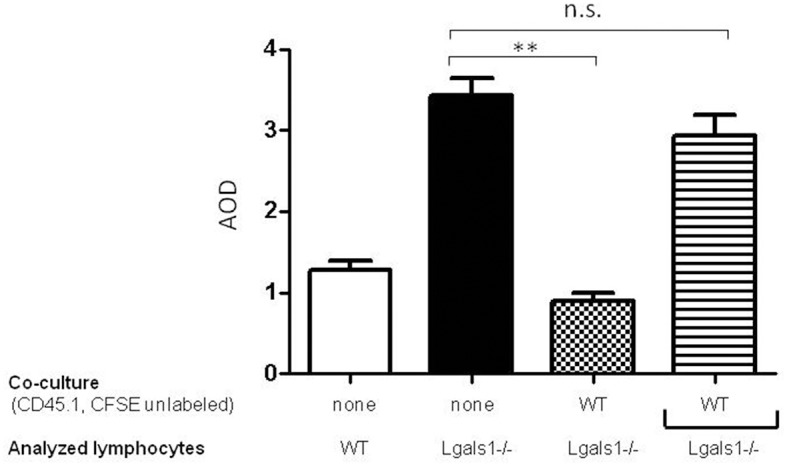
Endogenous Gal-1 regulates lymphocyte proliferation through cell-to-cell contacts. Lymphocytes from Lgals1-/- (black bars) and wild type (white bars) mice were polyclonally activated in presence of 1% TRAMP-C1 cells and 10% APC. Additionally, Lgals1-/- (CFSE labeled) and wild type (CD45.1; CFSE-) lymphocytes were co-cultured together or separated through a transwell. In all cases activation was performed by 0.25 μg/ml soluble anti-CD3 mAb. Proliferation was evaluated at 72 h by CFSE dilution in the CD8+ CD45.2+ gate. Results are expressed as average stage of division (AOD) and represent the mean + SD of three experiences. Statistic significance **p < 0.01 (Student t-test).